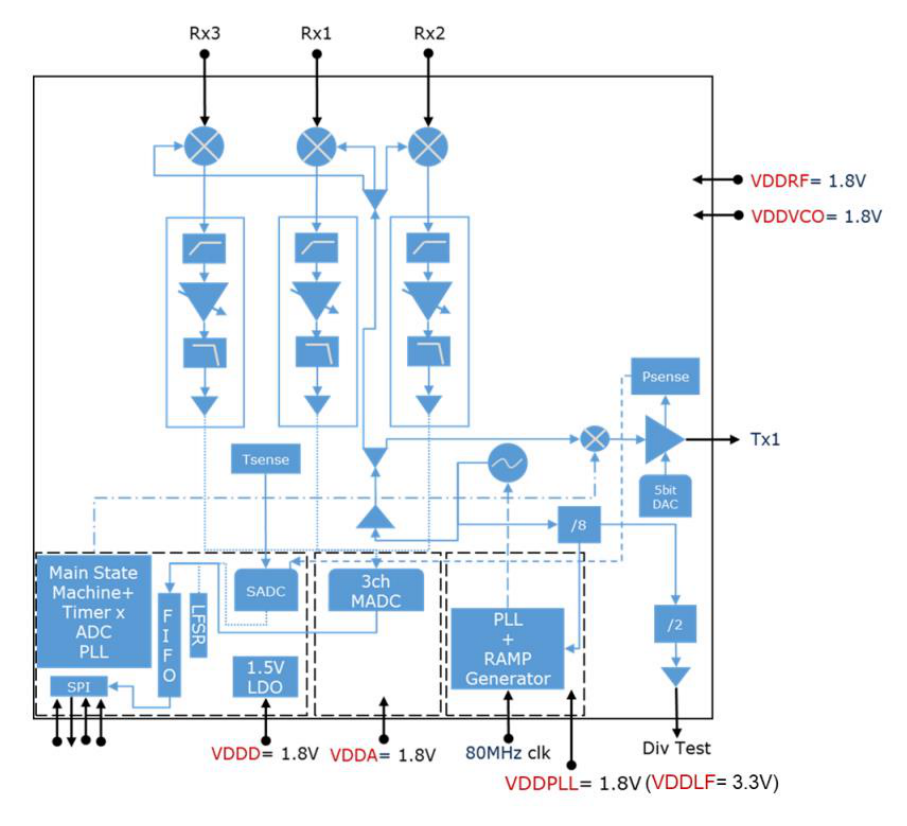
Figure 3. BGT60TR13C radar sensor block diagram [89]. The signal sensed by the three receiver channels (RX1, RX2, and RX3) is mixed with the transmitted signal from TX1, processed, and then converted digitally through the